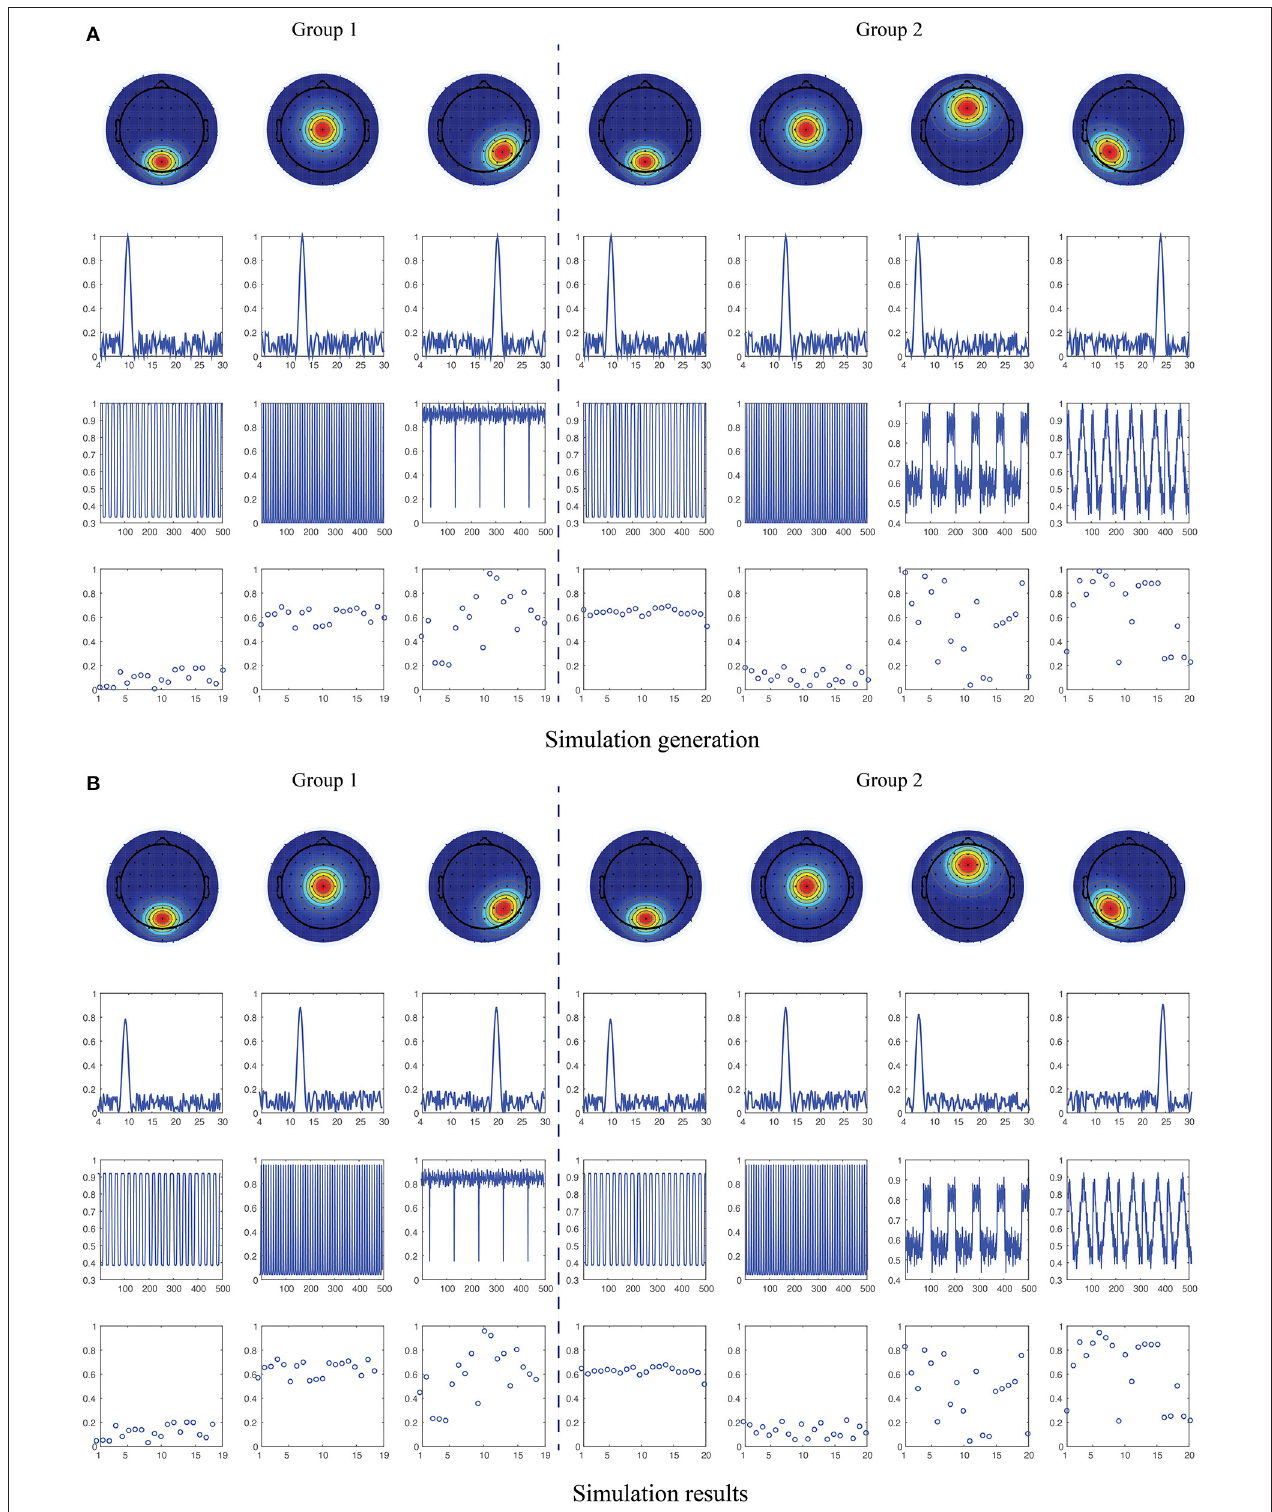
FIGURE 1 | Illustration of simulation generation and recovered results. (A) Simulated spatial, spectral, temporal and participant patterns (from top to bottom) for the two groups with partially coupled constraints in the first two components of spatial, spectral and temporal modes (see them in the 1st, 2nd, 4th, and 5th columns). (B) Reconstructed spatial, spectral, temporal and participant patterns (from top to bottom) using constrained tensor factorization methods.